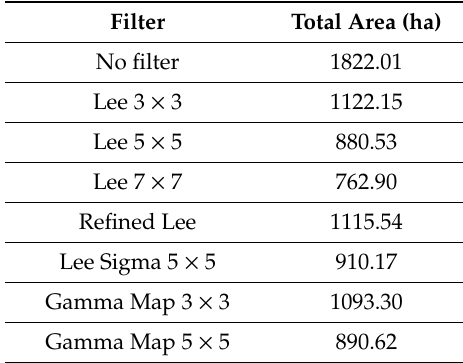
Table 4. Water covered area for a specific part of zone 3: Zaragoza–El Burgo de